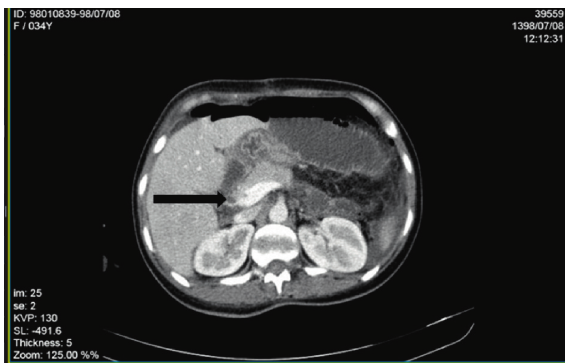
Figure 2: Thrombosis in main portal vein in spiral abdominal CT scan with IV contrast (black arrow).